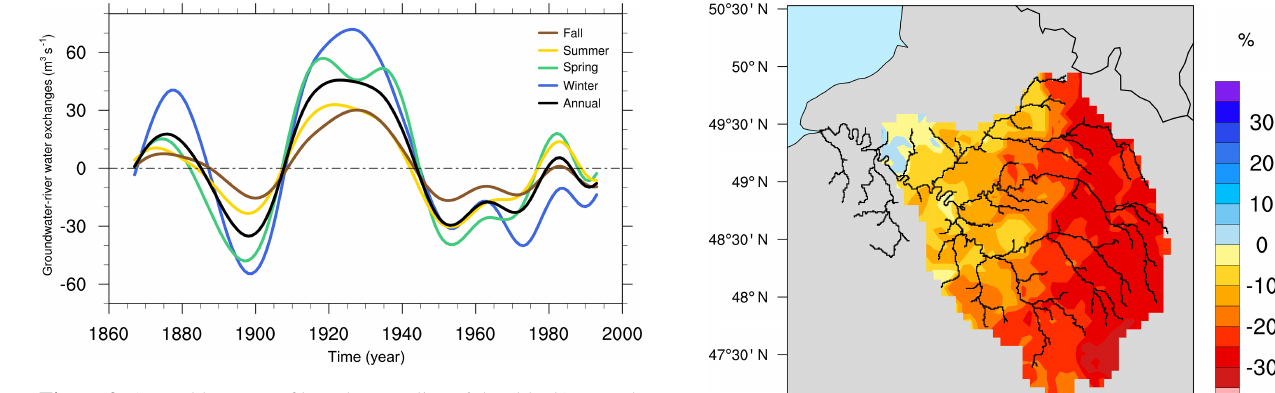
Figure 9. Annual low-pass-filtered anomalies of the (black) annual, (blue) winter, (green) spring, (yellow) summer and (brown) fall av- erage groundwater–river water exchanges over the Seine basin in the reconstruction. The reference period is 1852–2008. Figure 10. Relative differences (%) in the ratio between the total